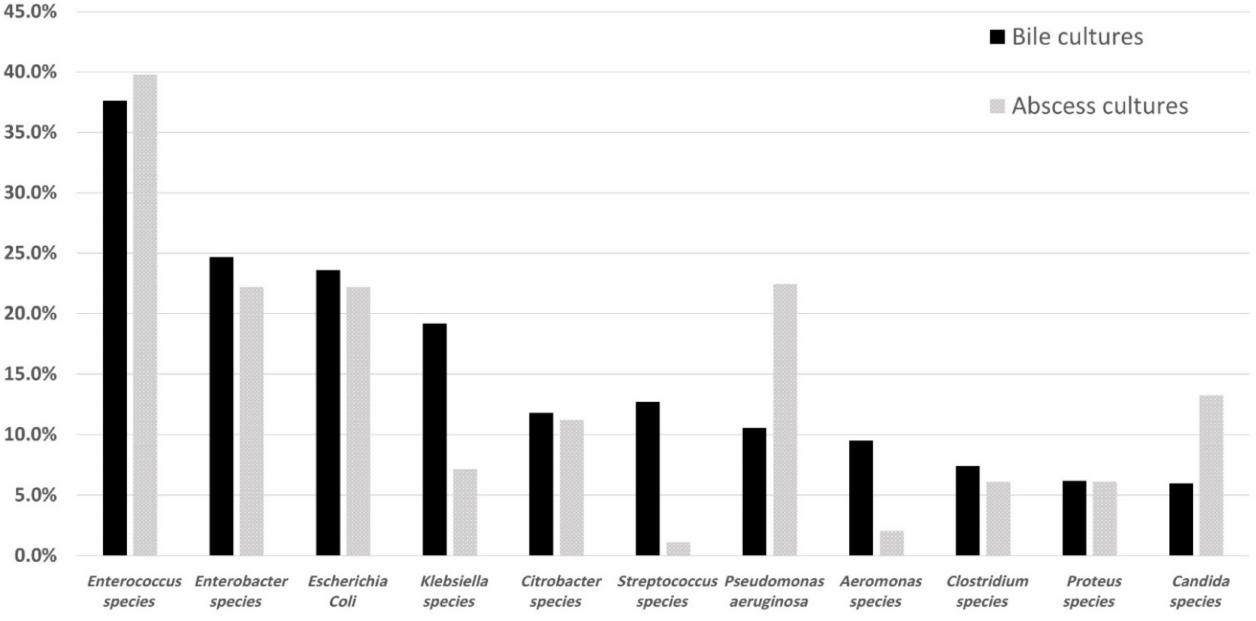
Figure 2. Comparison of microorganisms grown in intraoperative bile cultures and intra-abdominal abscess